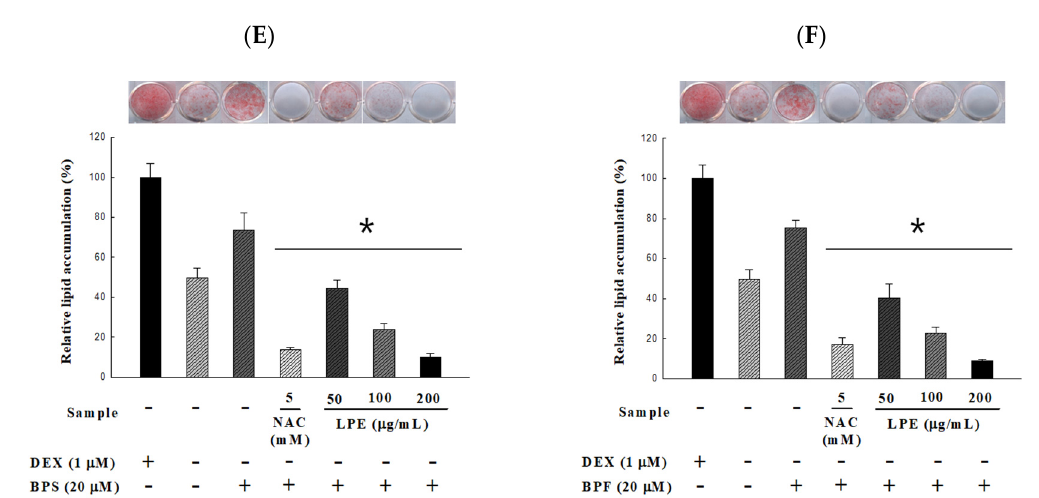
Figure 3. E ff ects of Potentilla rugulosa Nakai ethanolic extract (LPE) on BPA, BPS, and BPF-induced 3T3-L1 adipocyte in ( A – C ) cell viability and ( D – F ) lipid accumulation were determined by an XTT assay and ORO staining. 20 µ M of BPA, BPS and BPF were treated 6 days before preadipocytes di ff erentiation and maintained during cell di ff erentiation. Various concentrations of LPE were dissolved in DMSO and treated on 3T3-L1 adipocyte (added on day 0 of di ff erentiation) for 10 days. All values are presented as the mean ± SD. * p < 0.05 VS. MI treatment group, according to one-way analysis of variance.